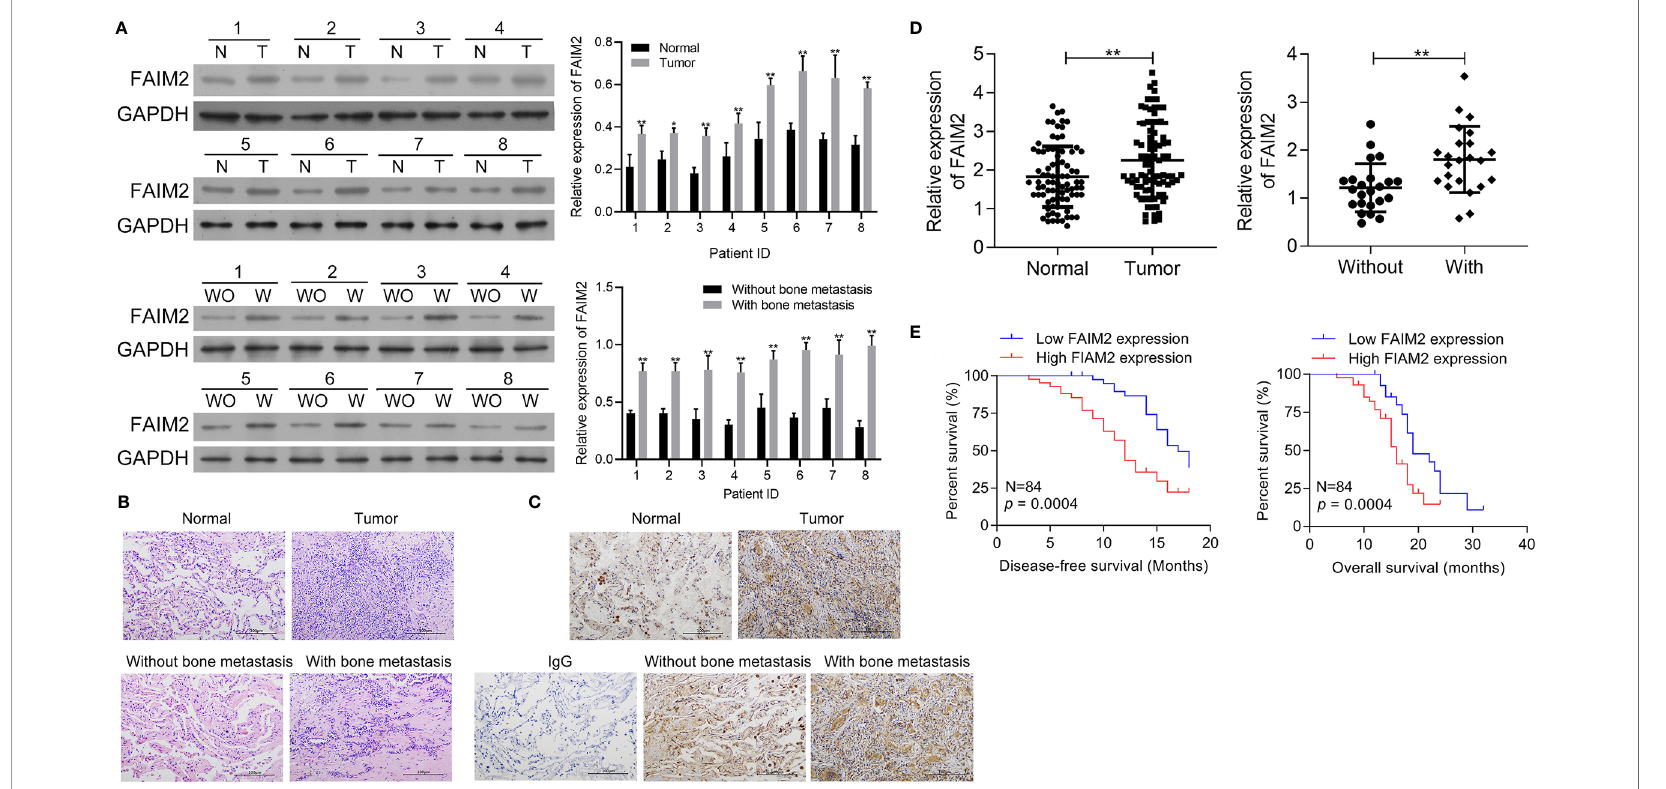
FIGURE 1 | FAIM2 was highly expressed in NSCLC and correlated with bone metastasis and a poor prognosis. (A) The levels of FAIM2 protein expression in normal lung tissues and NSCLC tissues, as well as in NSCLC tissues with (W) or without (WO) bone metastasis, were examined by Western blotting. (B) The microstructure of normal lung tissues and NSCLC tissues, as well as NSCLC tissues with (W) or without (WO) bone metastasis. (C, D) FAIM2 protein and mRNA expression in normal lung tissues and NSCLC tissues, as well as in NSCLC tissues with (W) or without (WO) bone metastasis, were examined by IHC and qRT- PCR. (E) Kaplan-Meier curves for the disease-free survival (DFS) and overall survival (OS) of patients with high and low levels of FAIM2. P < 0.05, *; P < 0.01, ** vs. Normal lung tissues or NSCLC tissues without bone